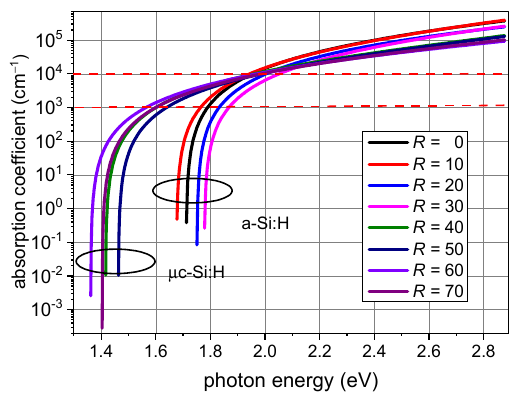
Figure 2. Absorption coefficients α [19].